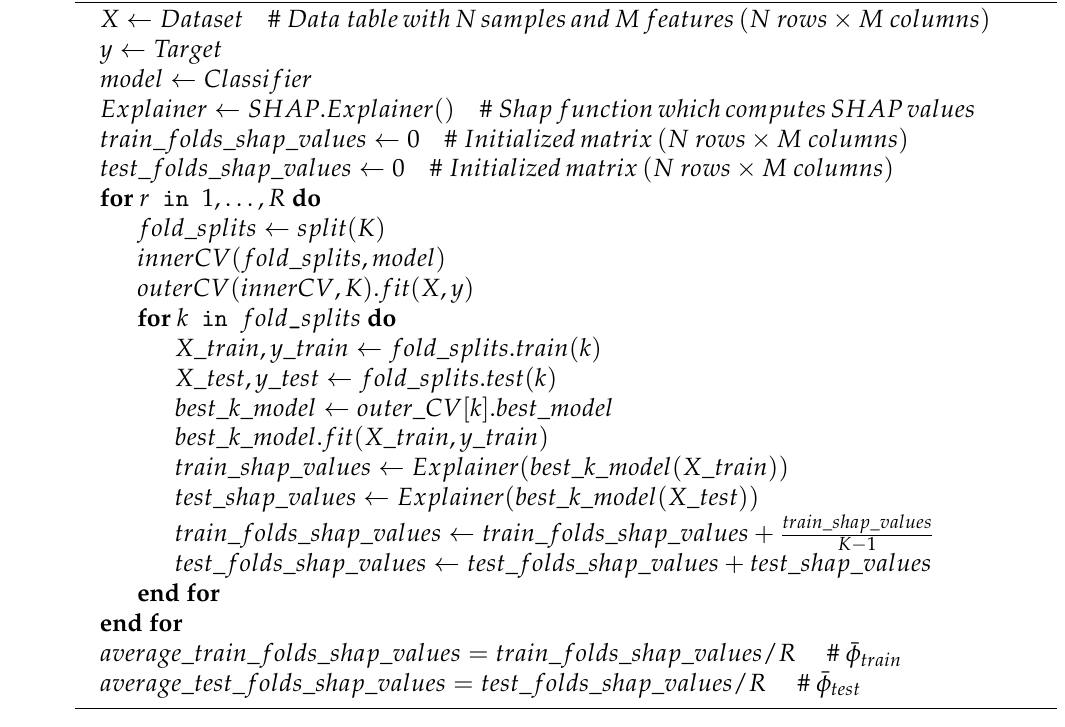
Algorithm 1 N : number of samples; M : number of features; K : number of folds; R : number of repetitions. X ← Dataset # Data table with N samples and M f eatures ( N rows × M columns